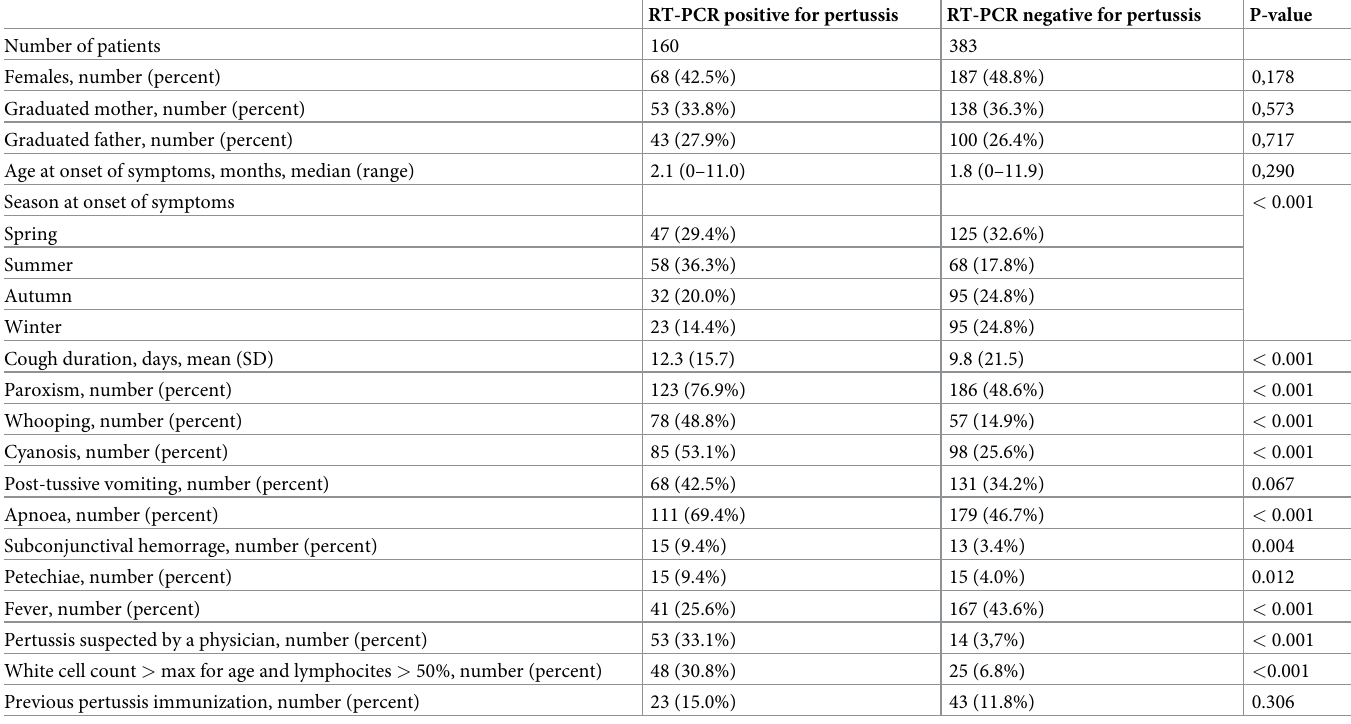
Table 1. General characteristics of children included in the